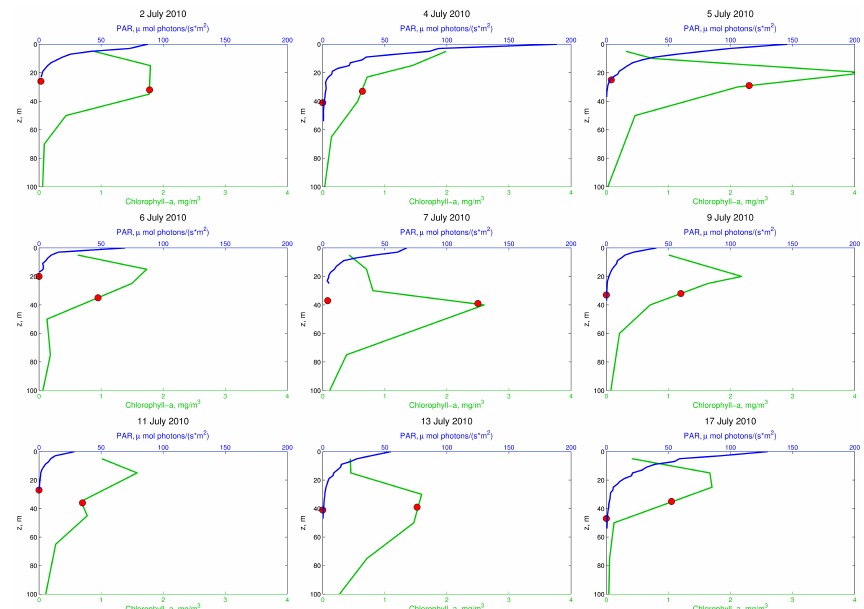
Fig. A1. Vertical profiles of PAR (photosynthetically active radiation) and CHL (chlorophyll a ) simultaneously taken in Greenland Sea in July 2010. Euphotic layer depths inferred from CHL profiles following Morel (1988) and calculated from PAR profile are marked as red circles on the corresponding profiles. Average error for Morel (1988) euphotic layer depth is 23% (Sect. 2.3). Data are from R/V Polarstern cruise.